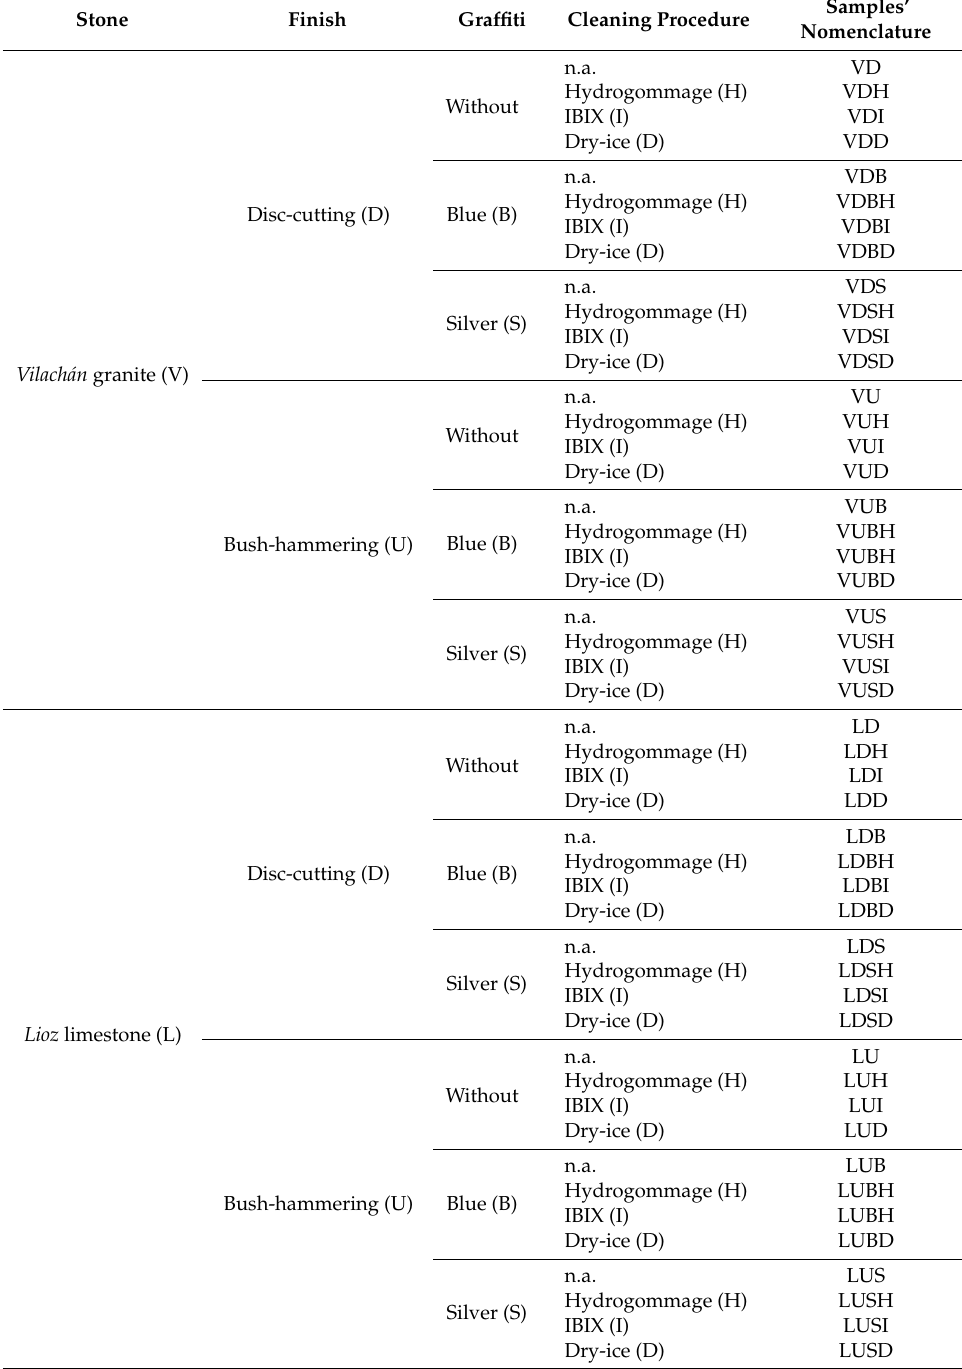
Table 1. Samples used in the experiment. Samples’ nomenclature is shown. (n.a.: not applied.)